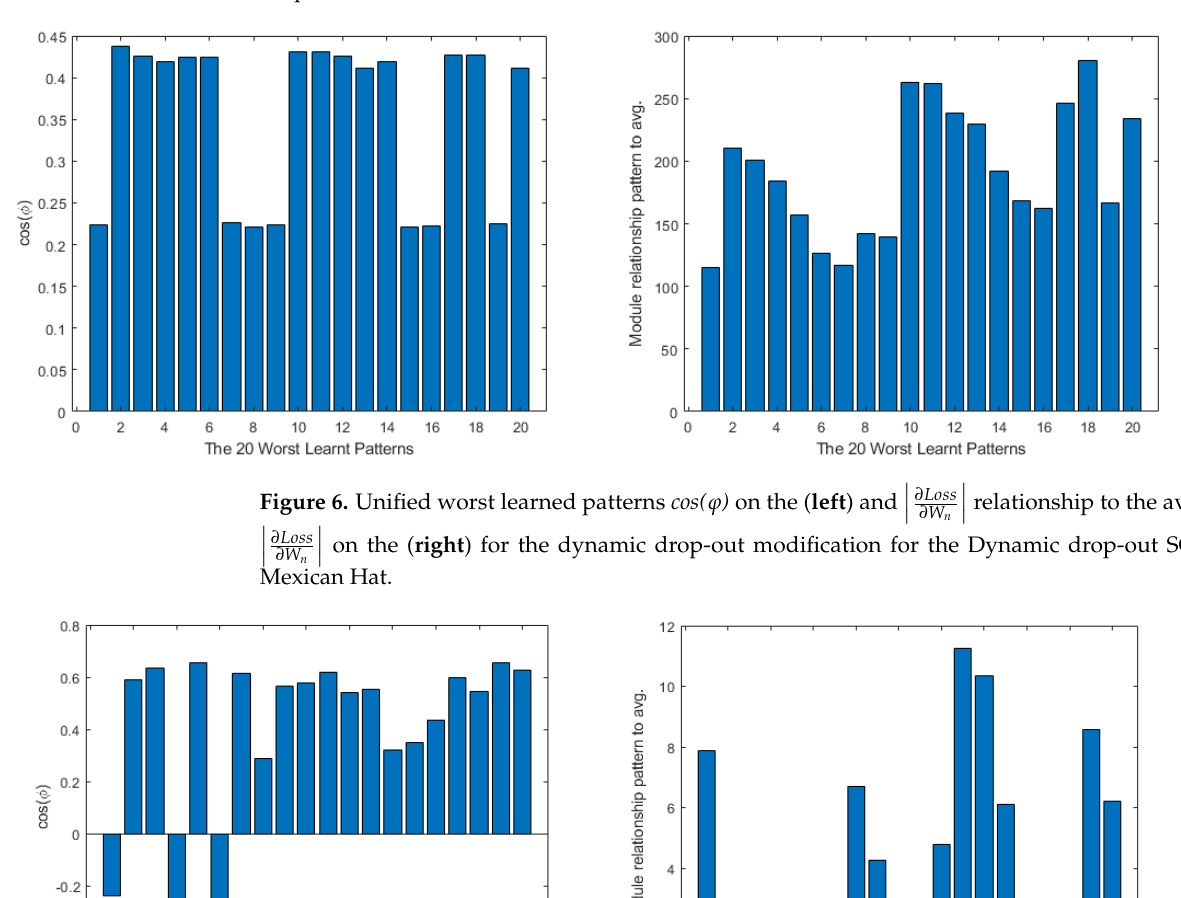
Figure 5. Average loss on training patterns in blue and validation patterns in orange for the Dynamic drop-out SGD of Mexican Hat.